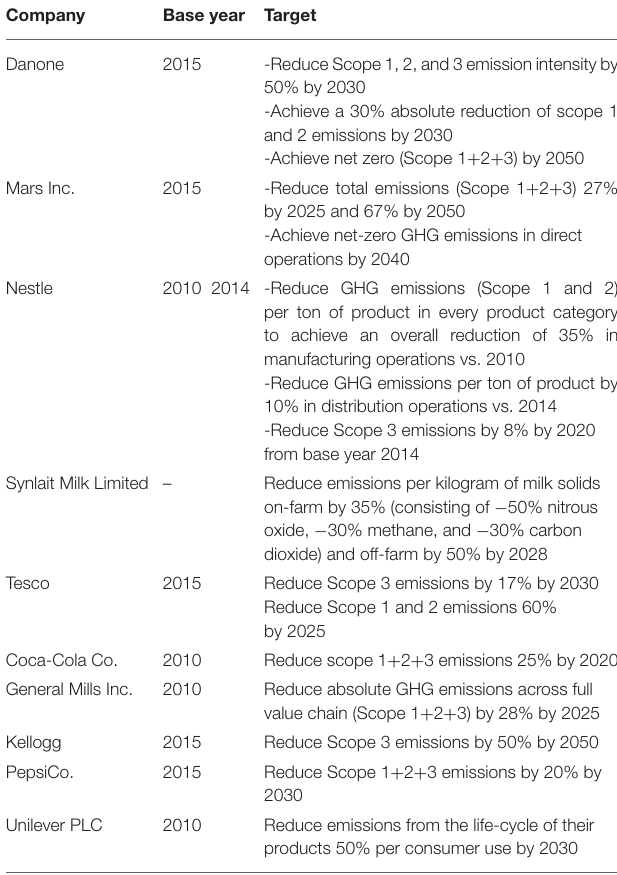
TABLE 1 | Greenhouse gas targets for selected major food